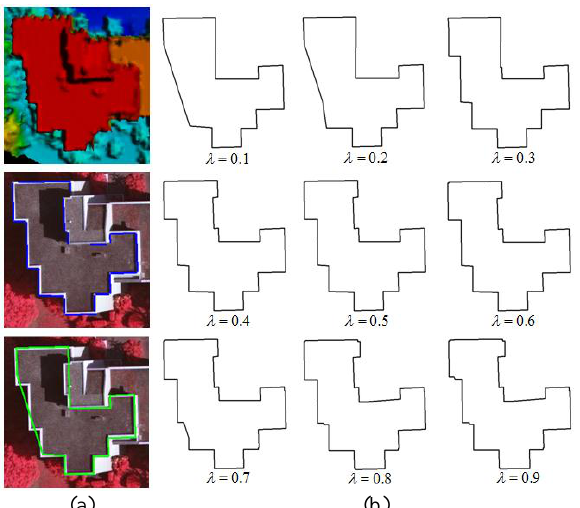
Figure 6. Development of rooftop polygon model with respect to .